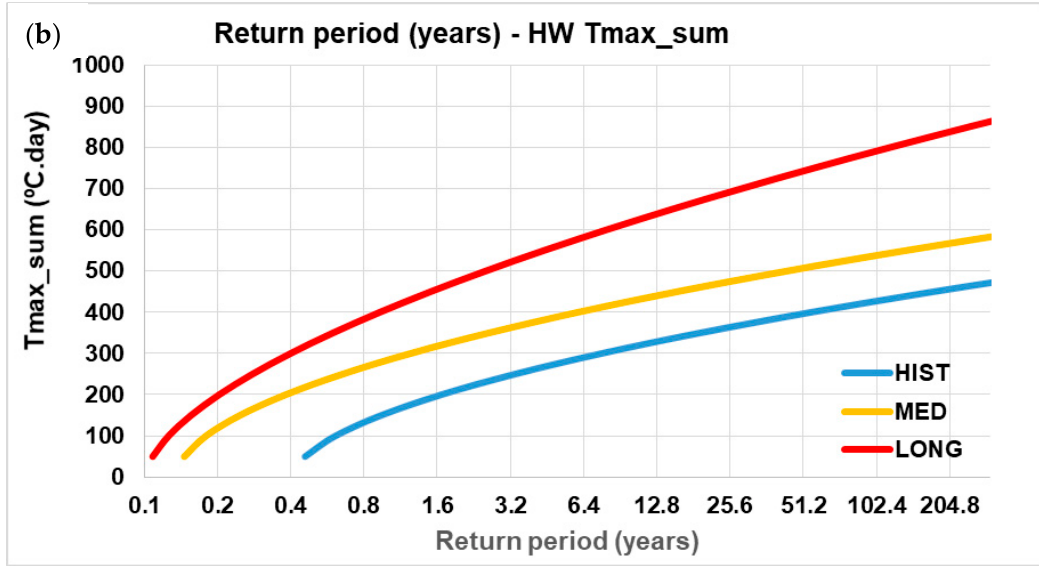
Figure 16. Return period of ( a ) NDAYS and ( b ) HW Tmax_sum, for HIST, MED, and LONG.